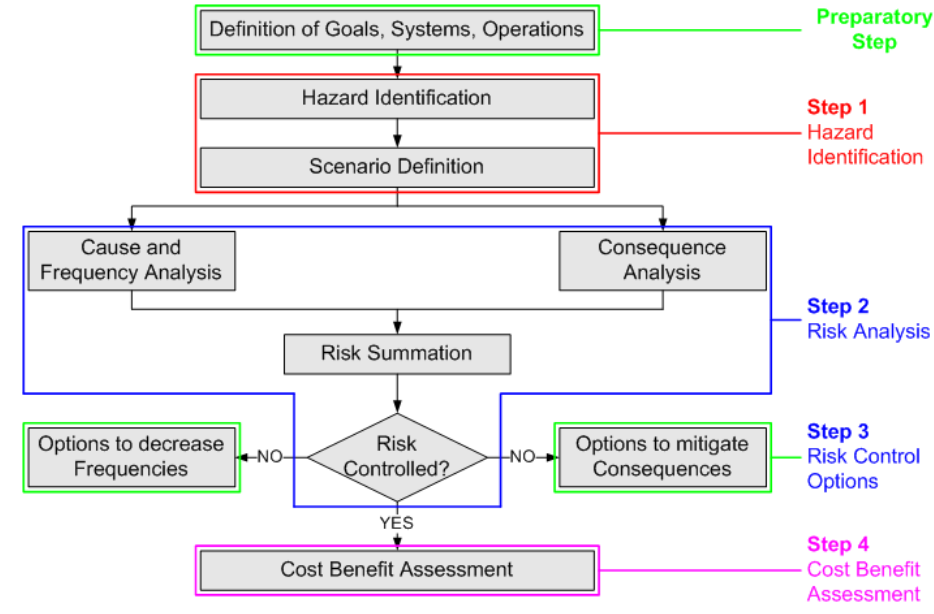
Figure 5. Steps of a risk analysis to determine the risk level in novel ship or ship